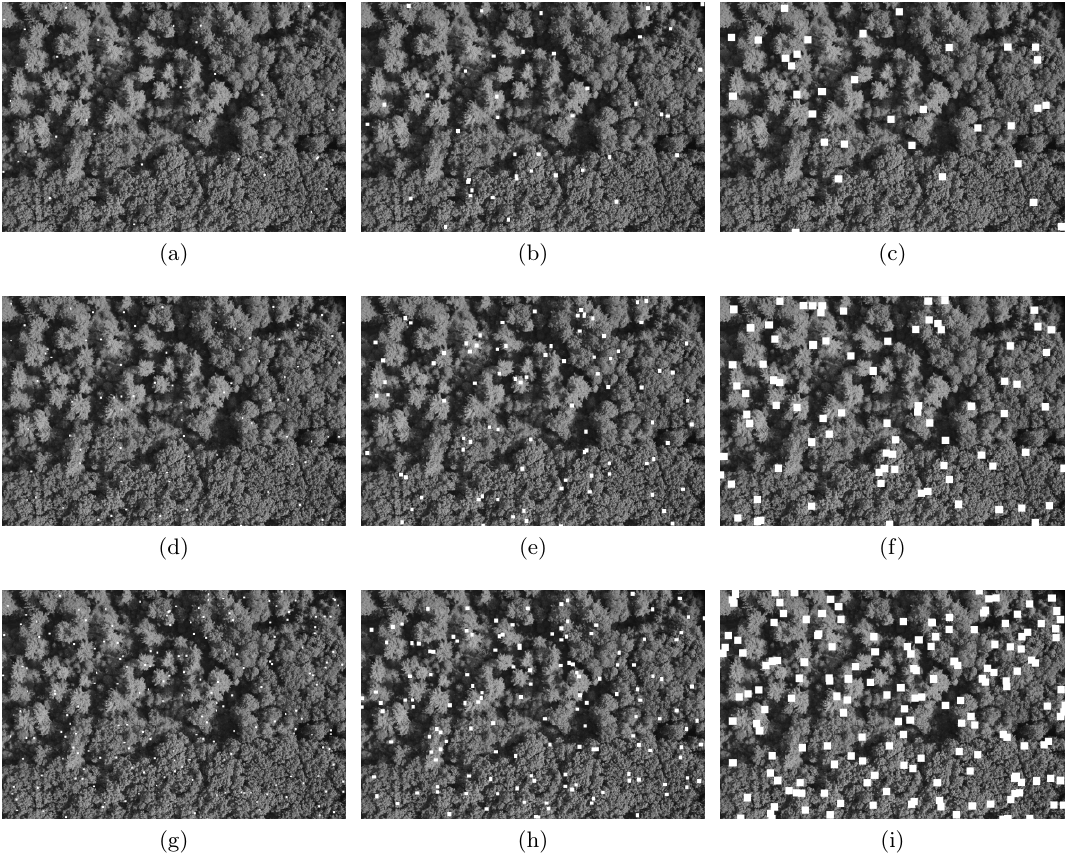
Figure 3. Contamination of of the reference image shown in Figure 1a by salt and pepper at random locations. The missing blocks are of size 15 × 15, 30 × 30, and 60 × 60, respectively, shown in the different columns. ( a – c ): the proportion of missing blocks is 0.000002; ( d – f ): the proportion of missing blocks is 0.000004; ( d – f ): the proportion of missing blocks is